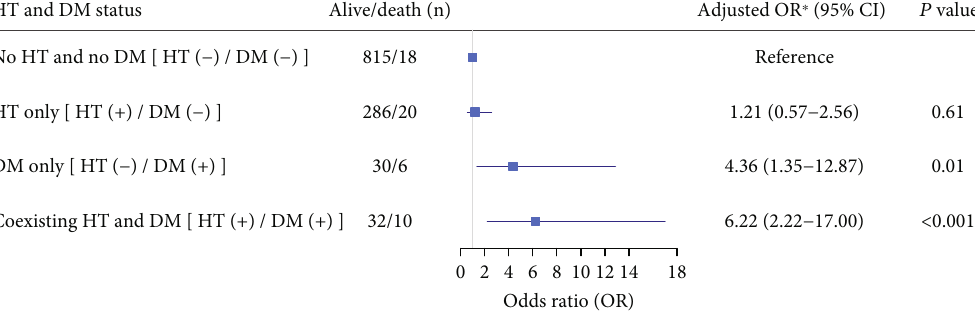
Figure 3: Multivariable logistic regression of di ff erent combinations of hypertension (HT) and diabetes mellitus (DM) status in association with all-cause mortality after 10-year follow-up. ∗ Model adjusted with sex, age, BMI, eGFR, and TG at baseline. P value < 0.05 was considered statistically signi fi cant. DM: diabetes mellitus; HT: